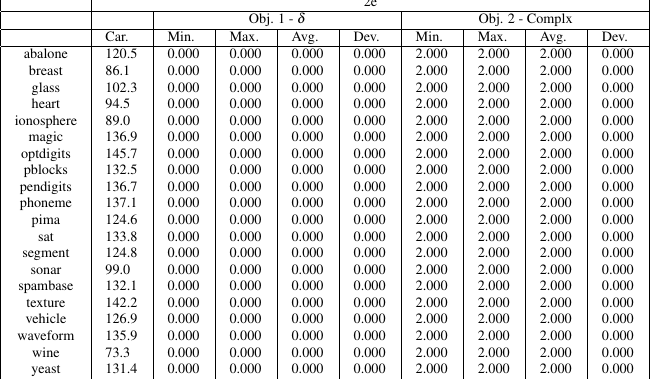
Table 5: Statistics of the Pareto front approximations with the original objectives.